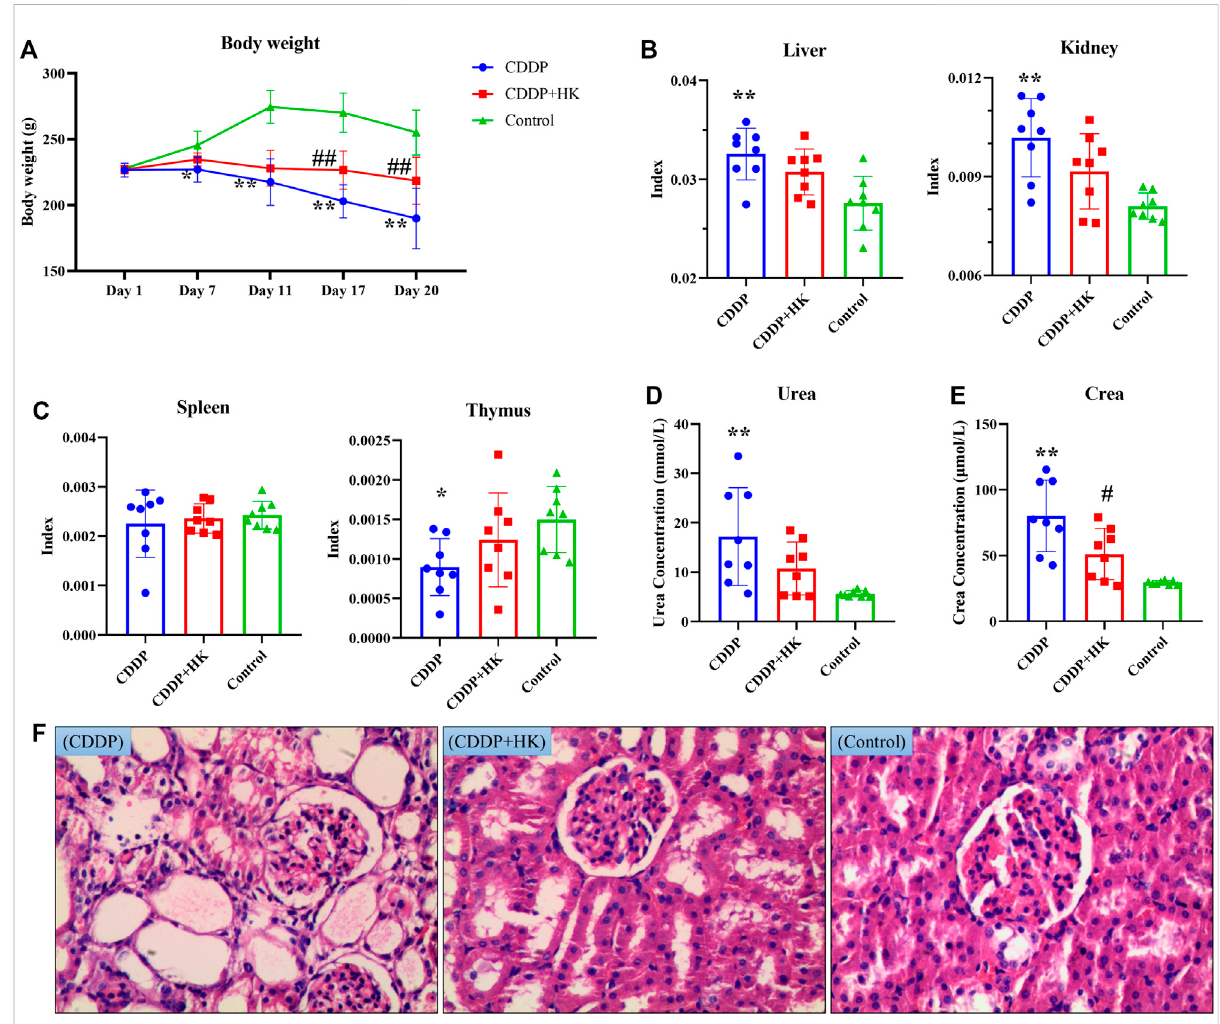
FIGURE 1 TheeffectsofHKonCDDP-inducedtoxicityrats. (A) Thechangesinbodyweight; (B) Liverandkidneyweightindifferentgroups; (C) Spleenand thymusweightindifferentgroups; (D) TheserumlevelofUrea; (E) TheserumlevelofCrea; (F) Representativehistopathologicalsectionofthekidney. Data were expressed as Mean ± SD in each group. * p < 0.05, ** p < 0.01, compared with Control group. # p < 0.05, ## p < 0.01, compared with CDDP